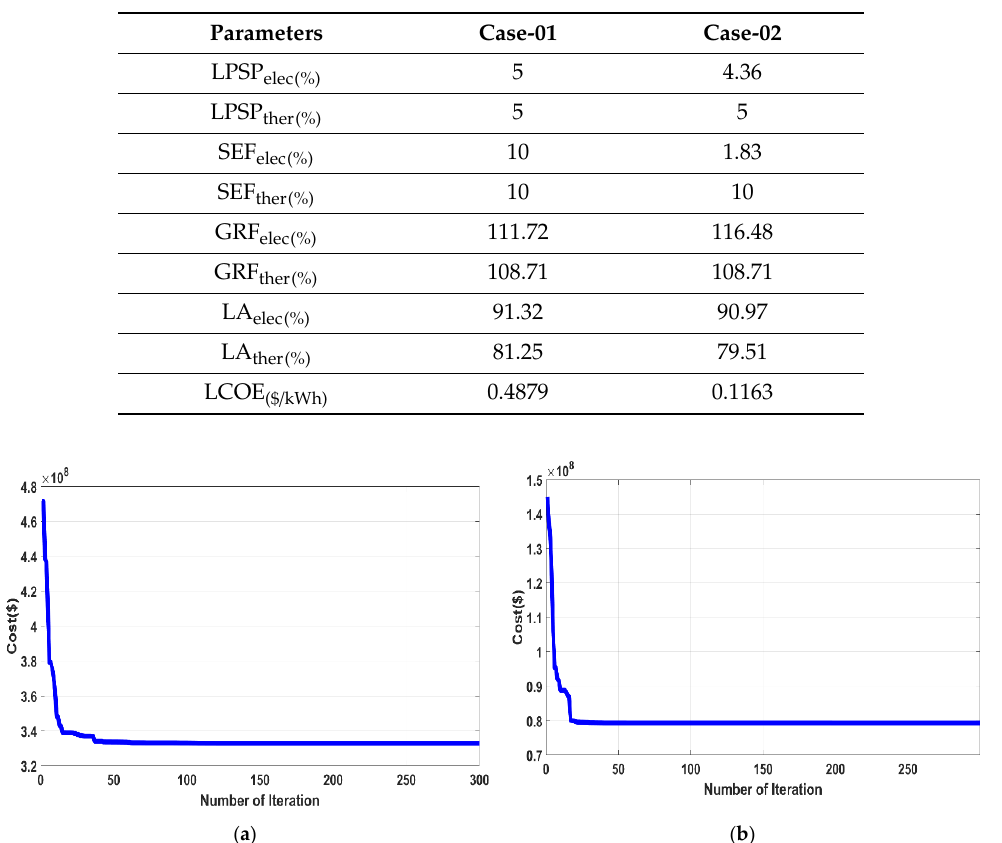
Table 4. Comparison of KPIs.